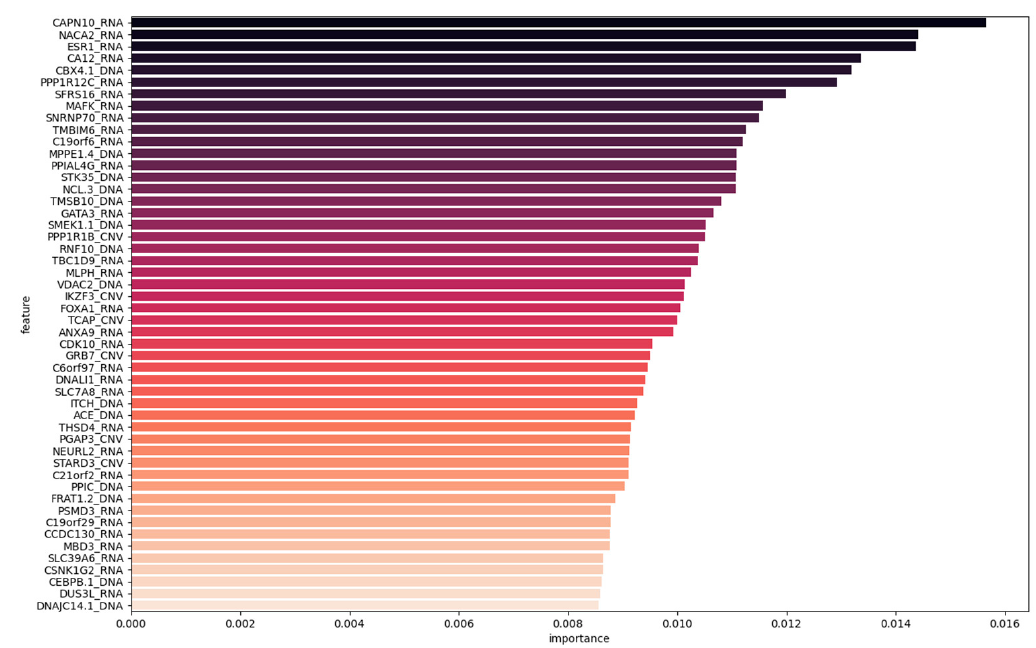
Figure 8. Extra trees classifier feature importance.